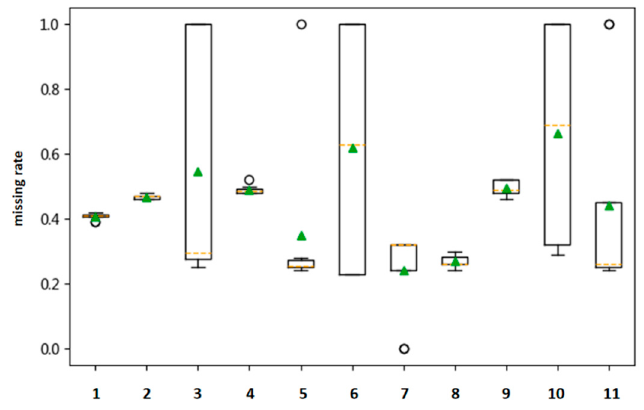
Figure 5. Data missing state of each company (11 companies in total).